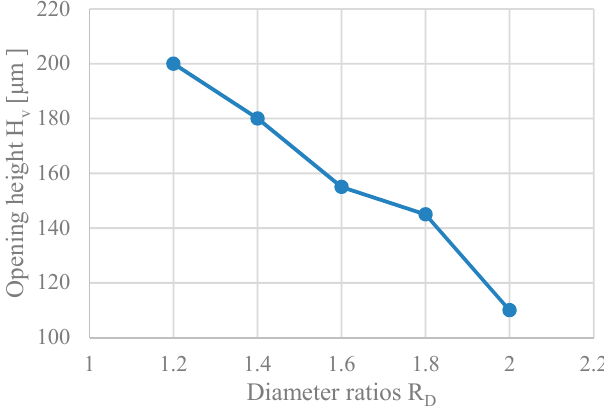
Figure 10. The relationship between diameter ratio R D and the valve opening height H v , when Thickness of the check valve t = 40 μ m.